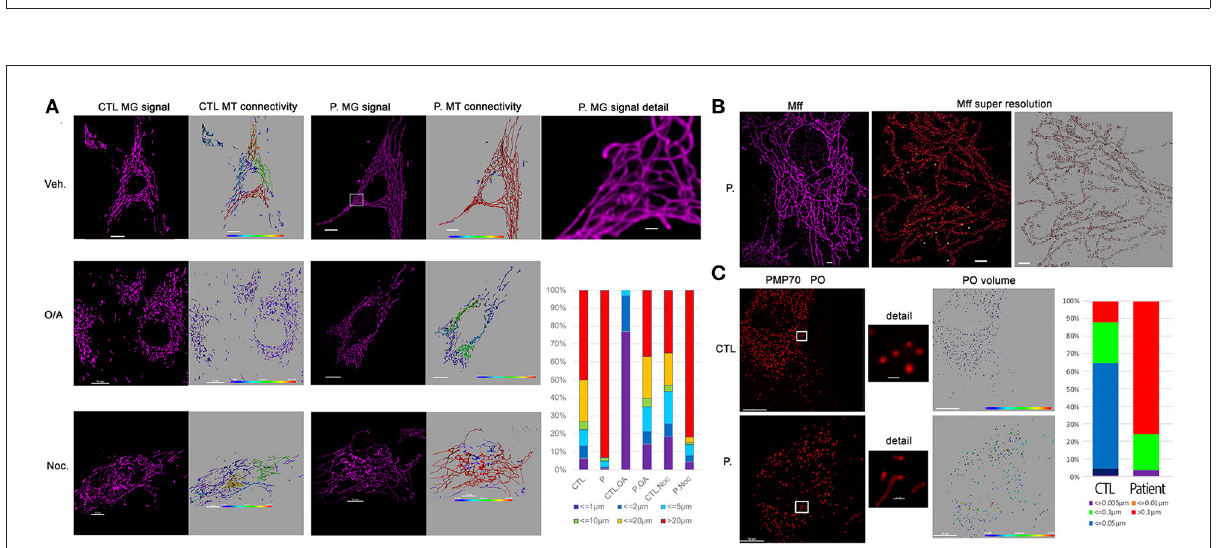
FIGURE2 Patient fibroblasts show highly connected mitochondrial network and elongation of peroxisome compare to control. (A) Representative fluorescent images of mitochondrial network structure (in purple) in control (CTL) and patient (P.) fibroblasts. Mitochondrial volume was assessed using the MitoTracker Green fluorescent signal which was analyzed using Imaris software. The color code highlights the different lengths of the mitochondrial tubules with short isolated mitochondria in violet and connected network in red. To present the changes in mitochondrial morphology in patient’s cells, types of mitochondria were classified into six groups according to mitochondrial volume, for example, red color represents mitochondria > 20 µ m 3 . Oligomycin 4 µ g/ml coupled to antimycin 2 µ g/ml (O/A) treatment leads to mitochondrial fission within 4h in CTL cells. 6h nocodazole (Noc), 10 µ M disrupts microtubules. (B) Immunostaining against mitochondrial Mff DRP1 receptor. Representative TIRF image of mitochondria (left, in purple) shows the hyper-connectivity of the network. Single-molecule localization microscopy dSTORM was used to analyze mitochondrial MFF distribution. The white dots are the fiducial signals used to control drift during acquisition. Scale bar: 2 µ m. (C) Immunostaining against peroxisomal PMP70 protein. Peroxisome (PO) volume was assessed using fluorescent signal by Imaris software and color-coded. To present the changes in peroxisome morphology in patient’s cells, types of Peroxisomes were classified into five groups according to peroxisome volume, for example, red color represents peroxisomes > 20 µ m 3 . Scale bar = 10 µ m; Scale bar in details 1 µ